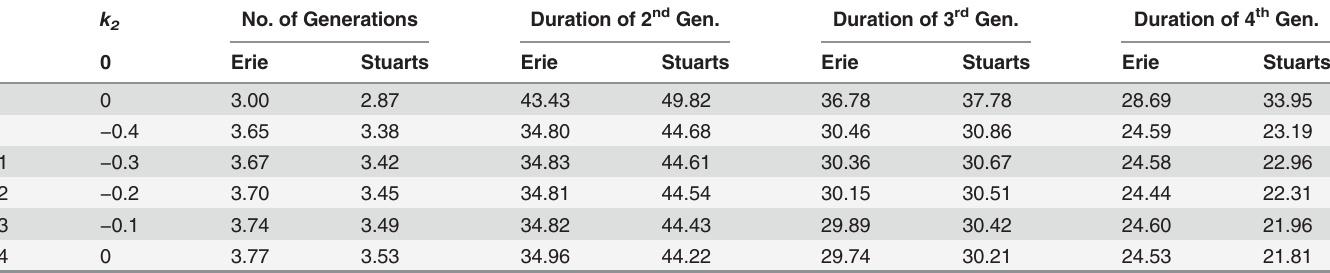
Table 3. Comparison of Number of Generations, Duration of 2 nd -4 th Generations under Various Climate Change Conditions at Erie, PA and Stuarts Draft, VA.